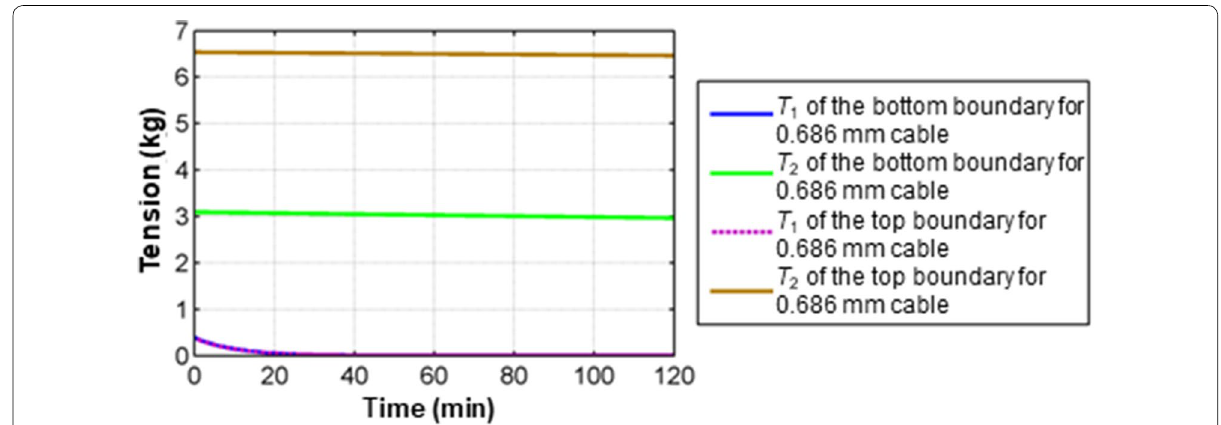
Figure 7 Boundaries of the cable of diameter 0.686 mm divided into four